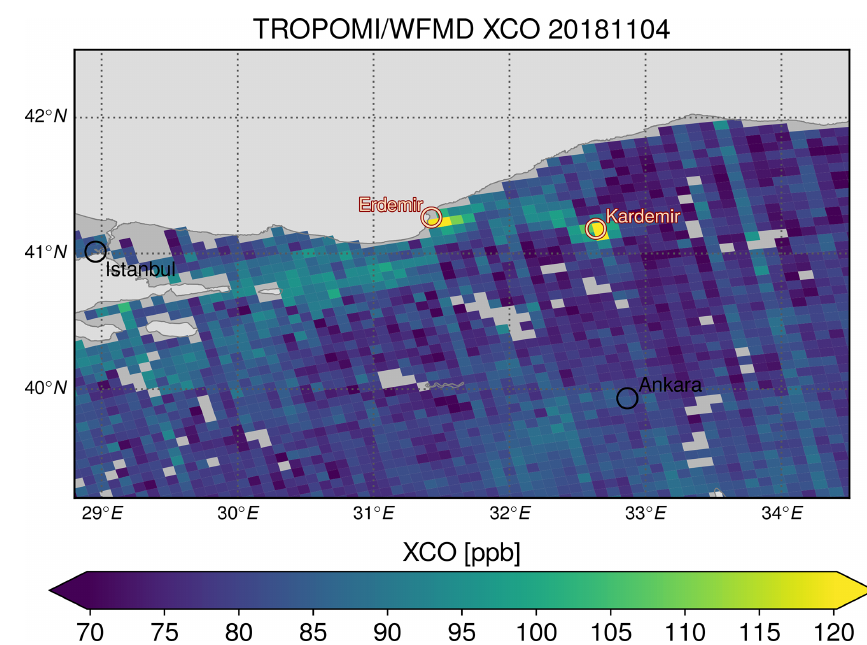
Figure 19. Carbon monoxide enhancement due to emissions from steel plants in